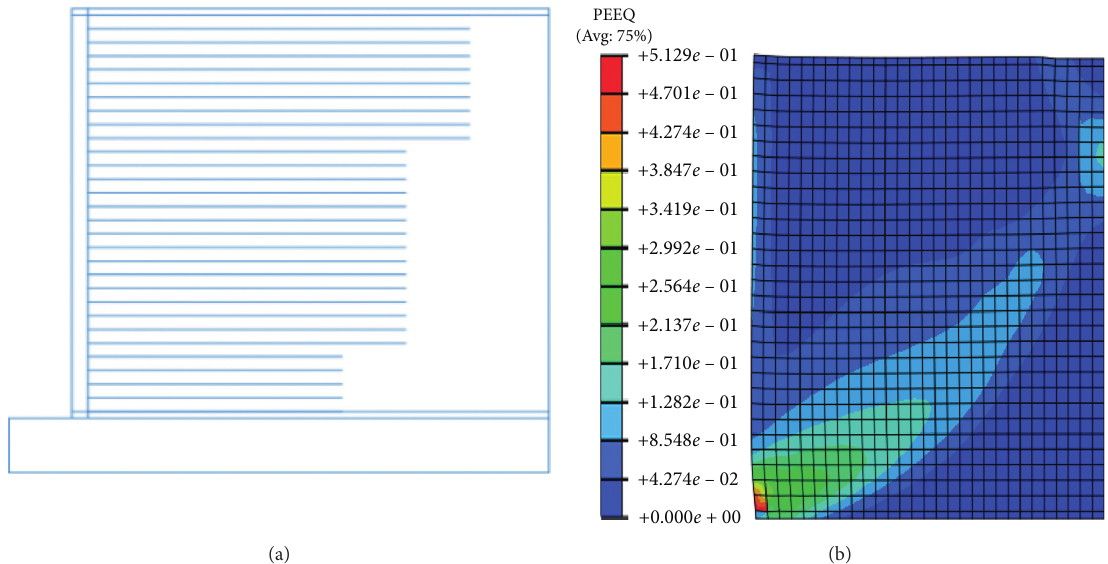
Figure 6: Plastic strain distribution. (a) Distribution of tie bars in soil. (b) Equivalent plastic